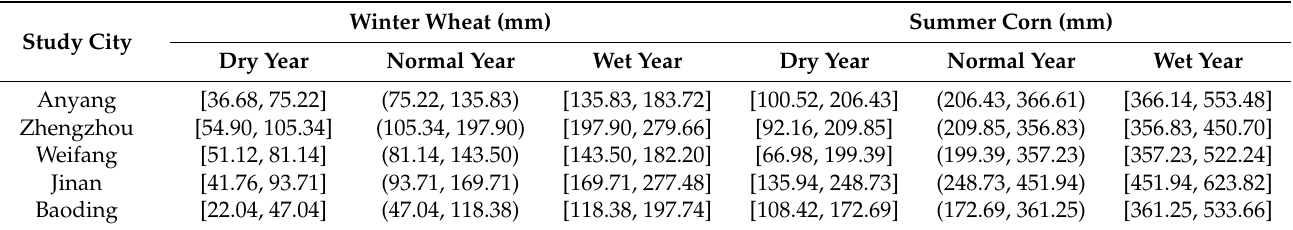
Table 8. Chance-constrained interval parameter of effective precipitation in five study